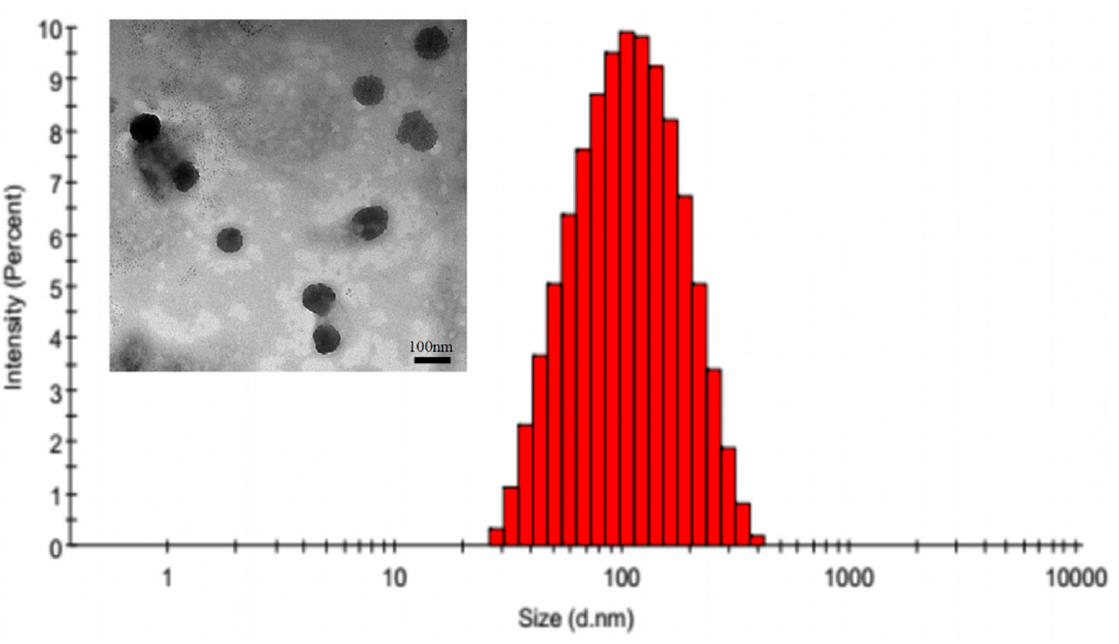
Figure 3. Typical size distribution determined by DLS and TEM micrograph of the Spm-PEG-PCL/DOX micelles; scale bar is 100 nm.